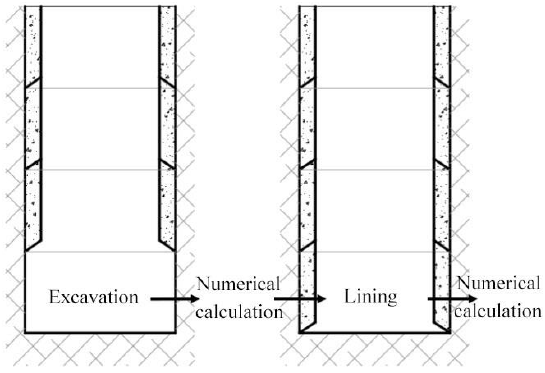
Figure 9. Calculation process of the original excavation plan.